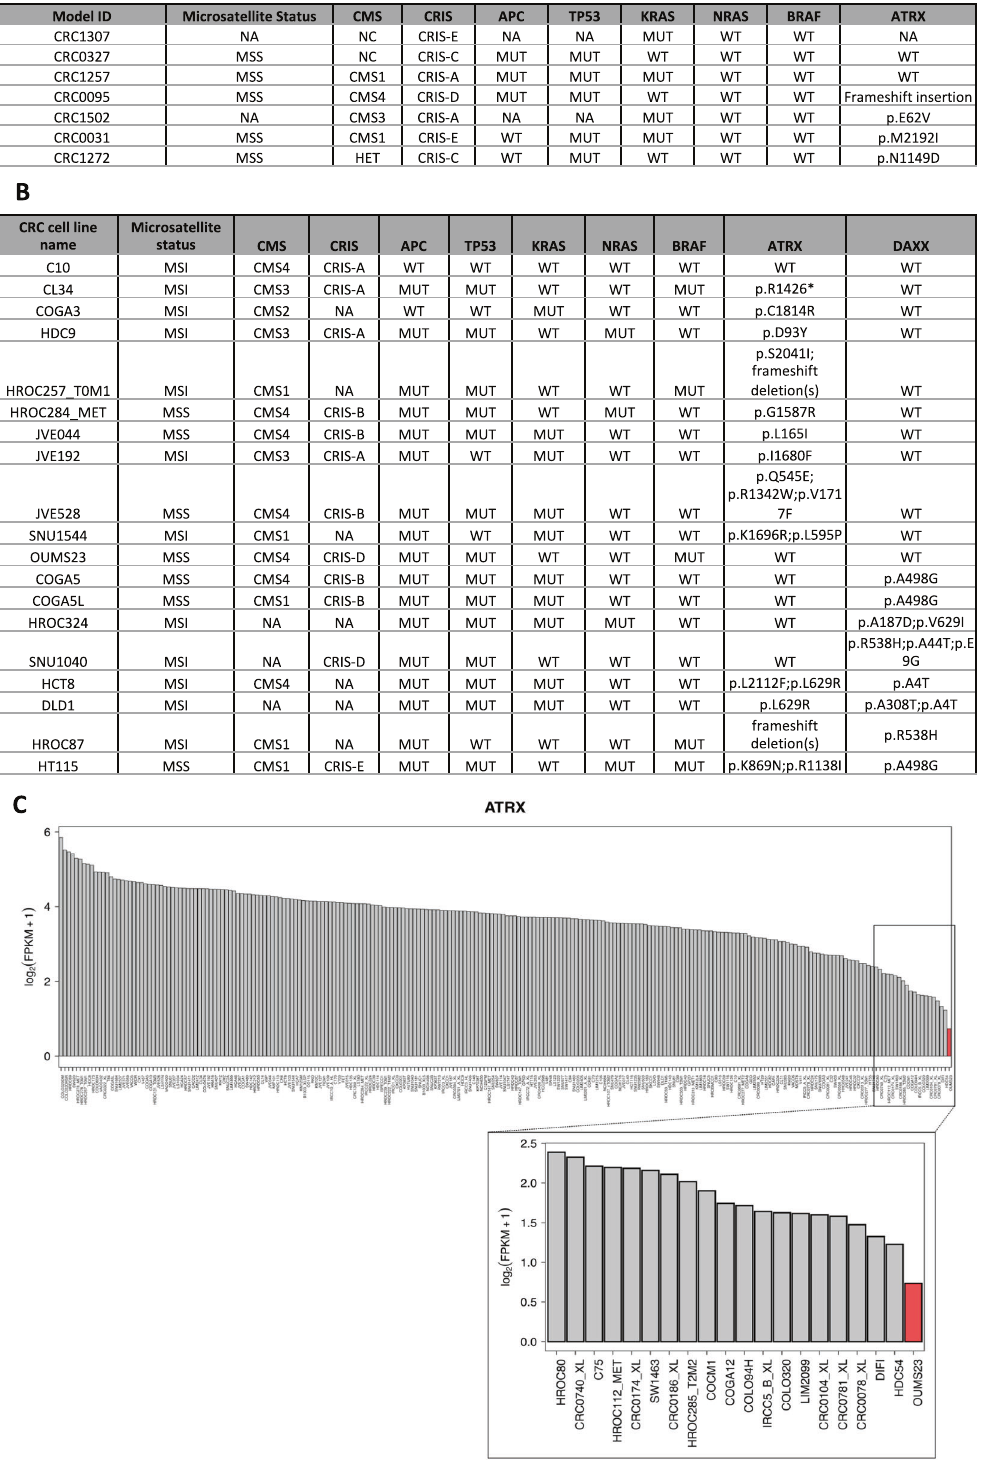
Cell Death and Disease (2023)